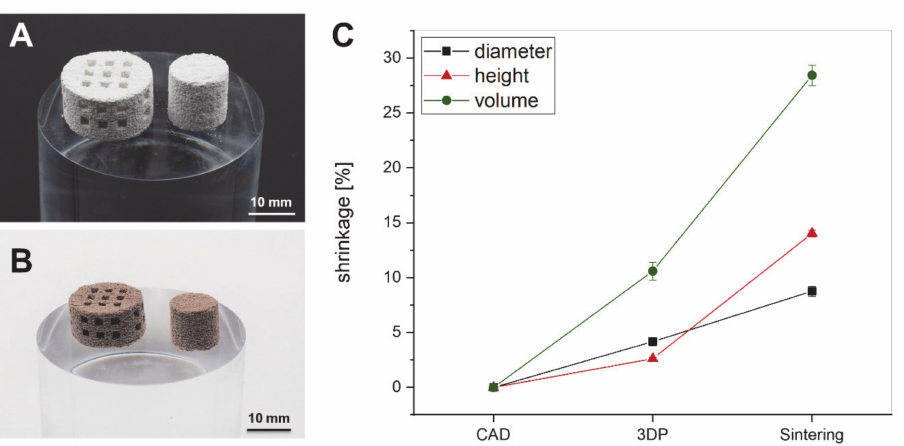
Figure 5. Three-dimensional (3D) printed cylindrical and interconnected sca ff olds from BaTiO 3 / HA composite prior to debinding and sintering ( A , scale bar: 10 mm) and afterward ( B , scale bar: 10 mm). The shrinkage of the BaTiO 3 / HA sca ff olds classified into fabrication process (3DP) and sintering, representing the fidelity of the printing process and the impact of thermal post-treatment ( C